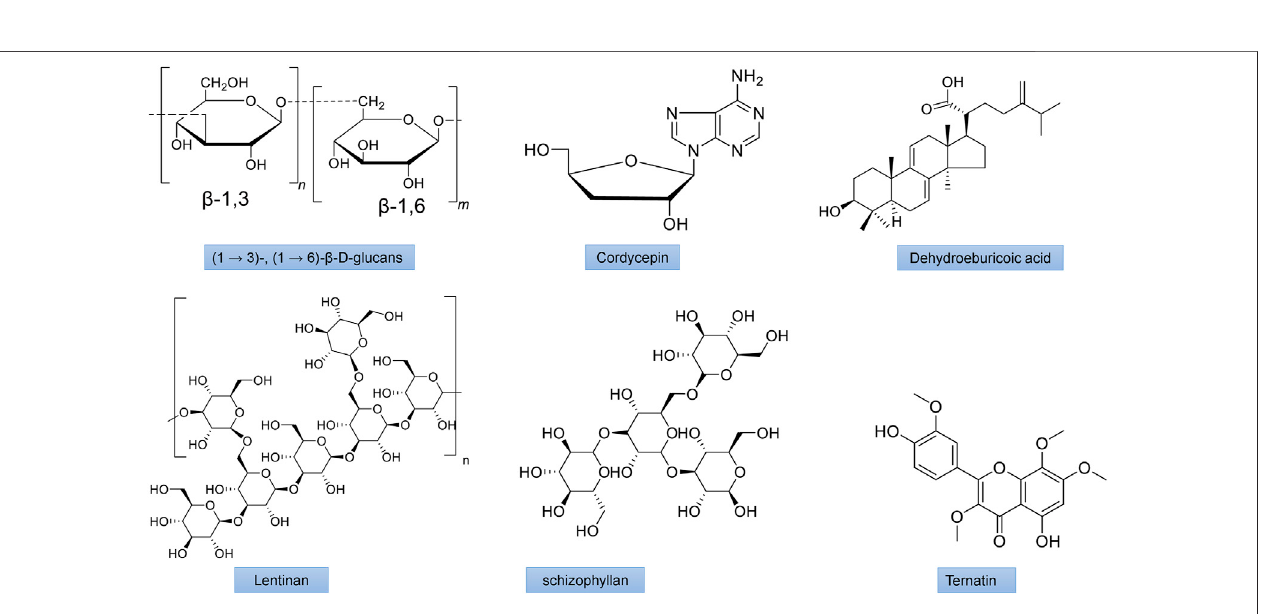
FIGURE 5 | The chemical structures of important mushroom antidiabetic activity compounds and polysaccharides. β -1,3/1,6 glucan from Agaricus blazei ; Cordycepin from Cordyceps militaris ; Dehydroeburicoic acid from Antrodia camphorate ; Lentinan from Lentinus edodes ; Schizophyllan from Schizophyllum commune ; Ternatin from Coriolus versicolor